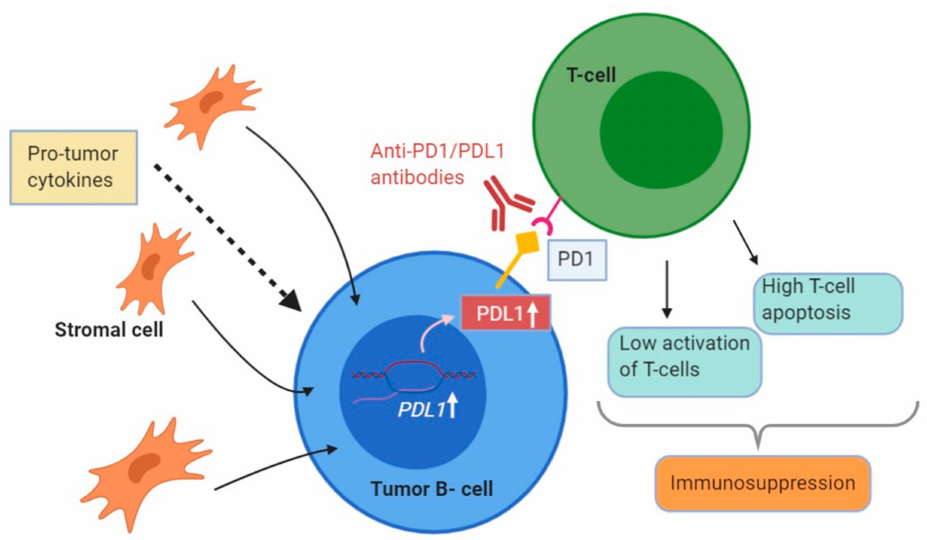
Figure 3. Schematic showing how the BM microenvironment can enhance PD-L1 expression on tumor cells, consequently leading to lower activation, greater apoptosis of T cells and higher